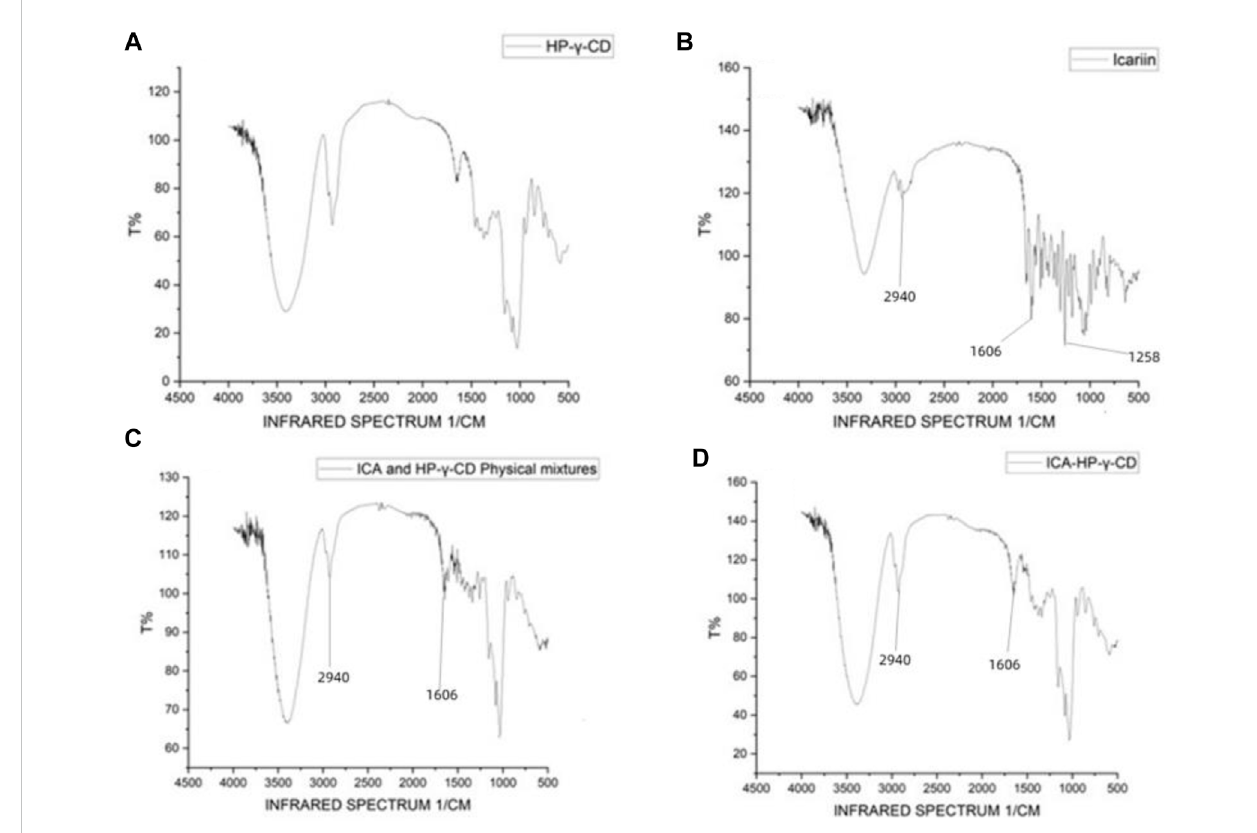
Fourier-transform infrared spectroscopy spectra of HP- γ -cyclodextrin (A) , icariin (B) , the physical mixture of HP- γ -cyclodextrin and icariin (C) , and their inclusion complex (D)